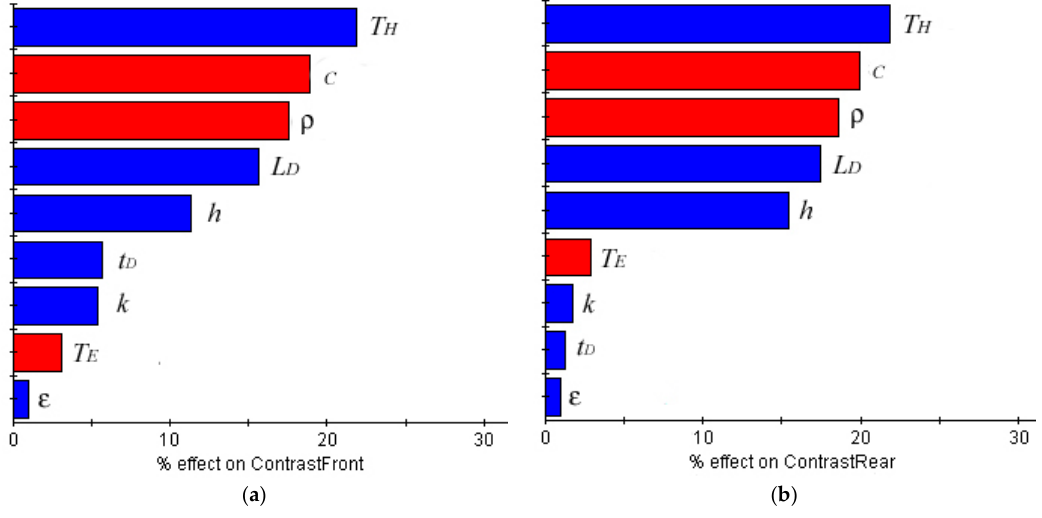
Figure 5. Pareto plot indicating the influence weight of each input variable in responses ( a )“Contrast